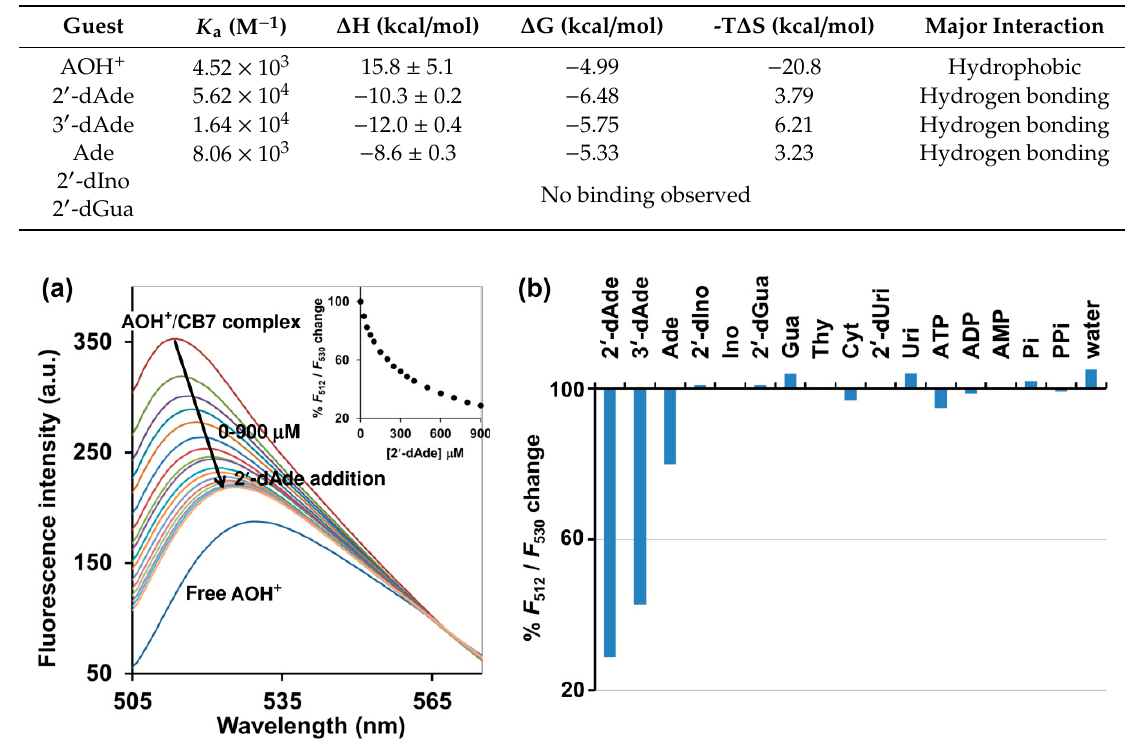
Figure 3. ( a ) Fluorescence spectrum of AOH + /CB7 complex upon addition of various concentrations of 2 ′ -dAde. The percentages of change ( F 512 / F 530 ) are shown in the inset. ( b ) % change ( F 512 / F 530 ) of the AOH + /CB7 complex upon addition of various analytes at 900 μ M. Measurement condition: 5 μ M